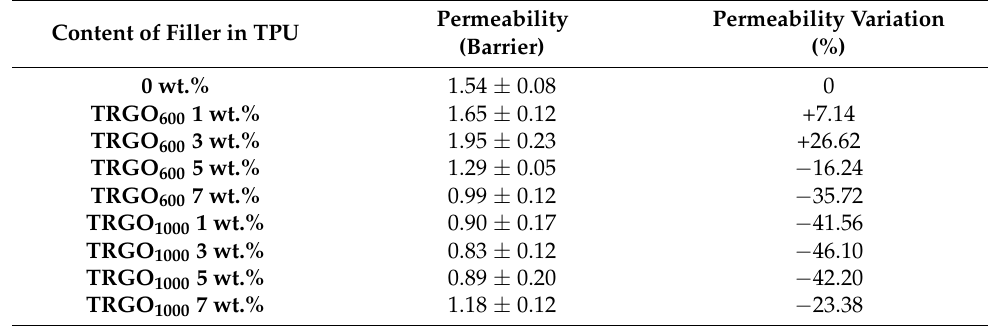
Table 5. Permeability of TPU and TPU-based